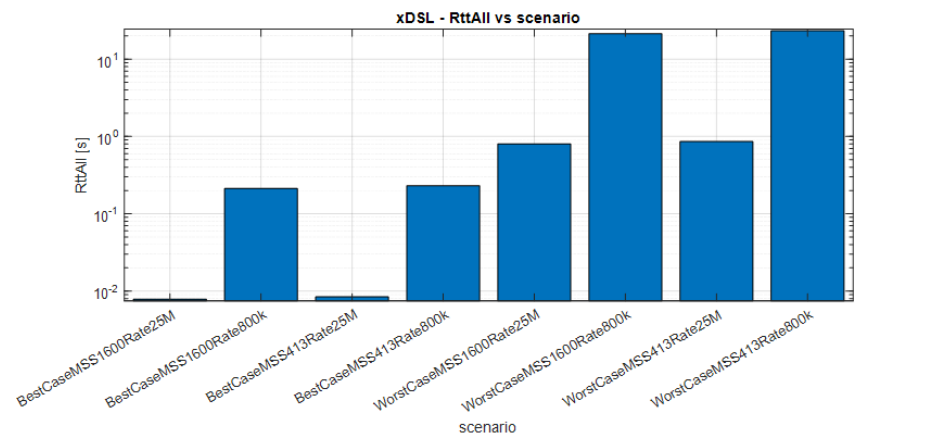
Figure 11. RTTAll sensitivity with respect to the Maximum Segment Size for Scenario